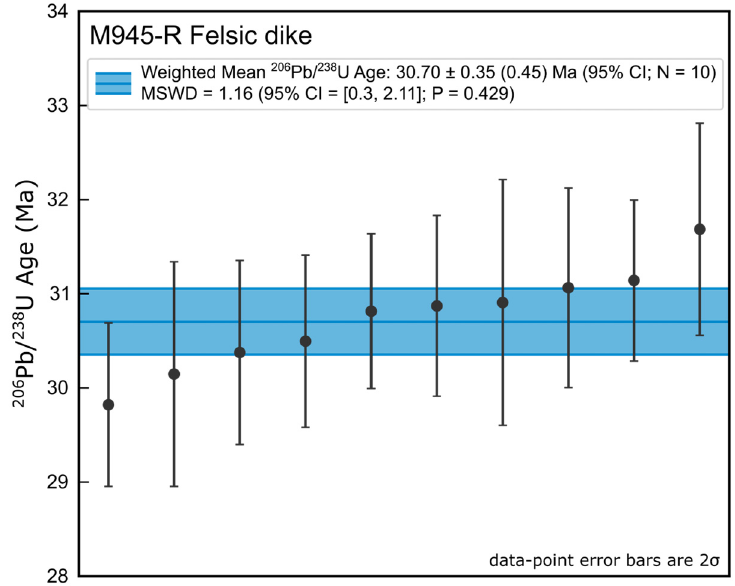
Figure 7. Weighted mean of 10 SHRIMP-RG 206 Pb/ 238 U results for magmatic zones of 9 zircons from sample M945-R. External age uncertainties (in parentheses following the internal uncertainties) include the uncertainty in the age of the standard R33 [43].